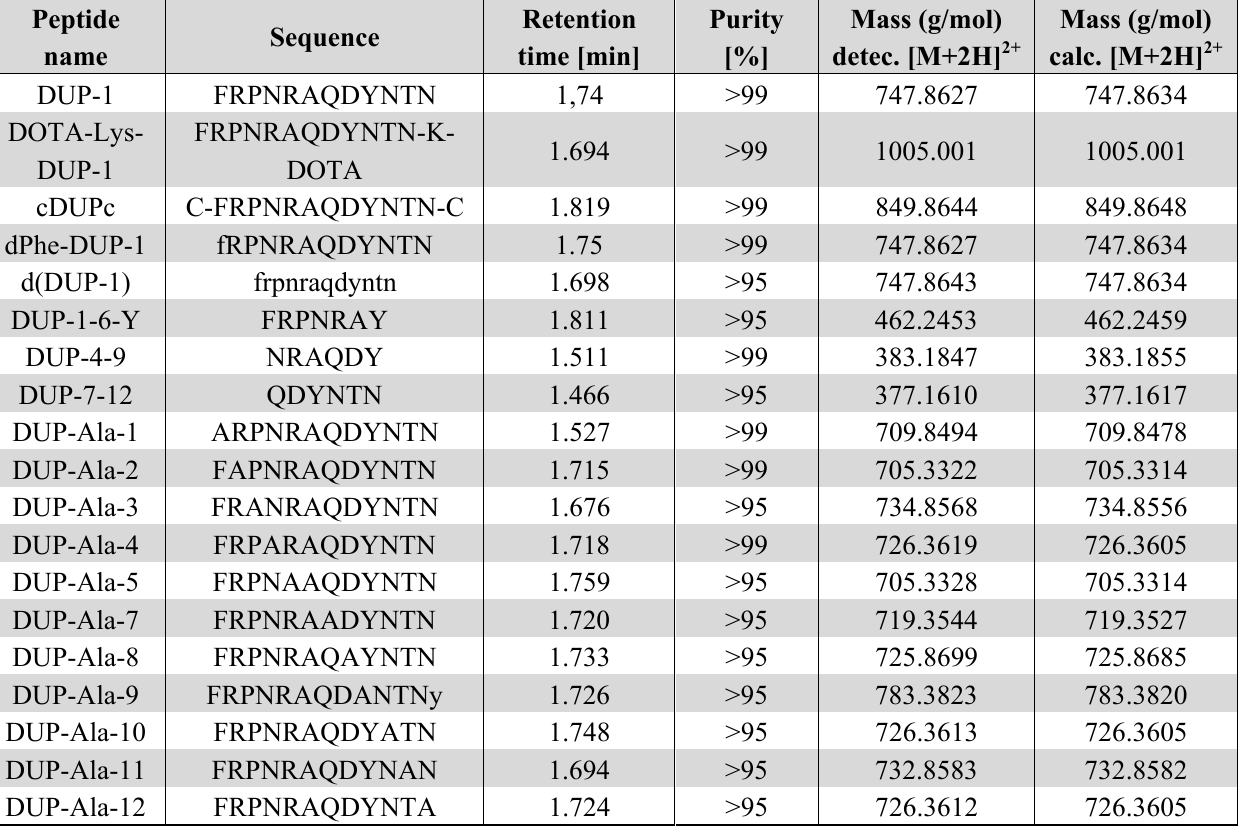
Table 1. Analytical data of synthesized